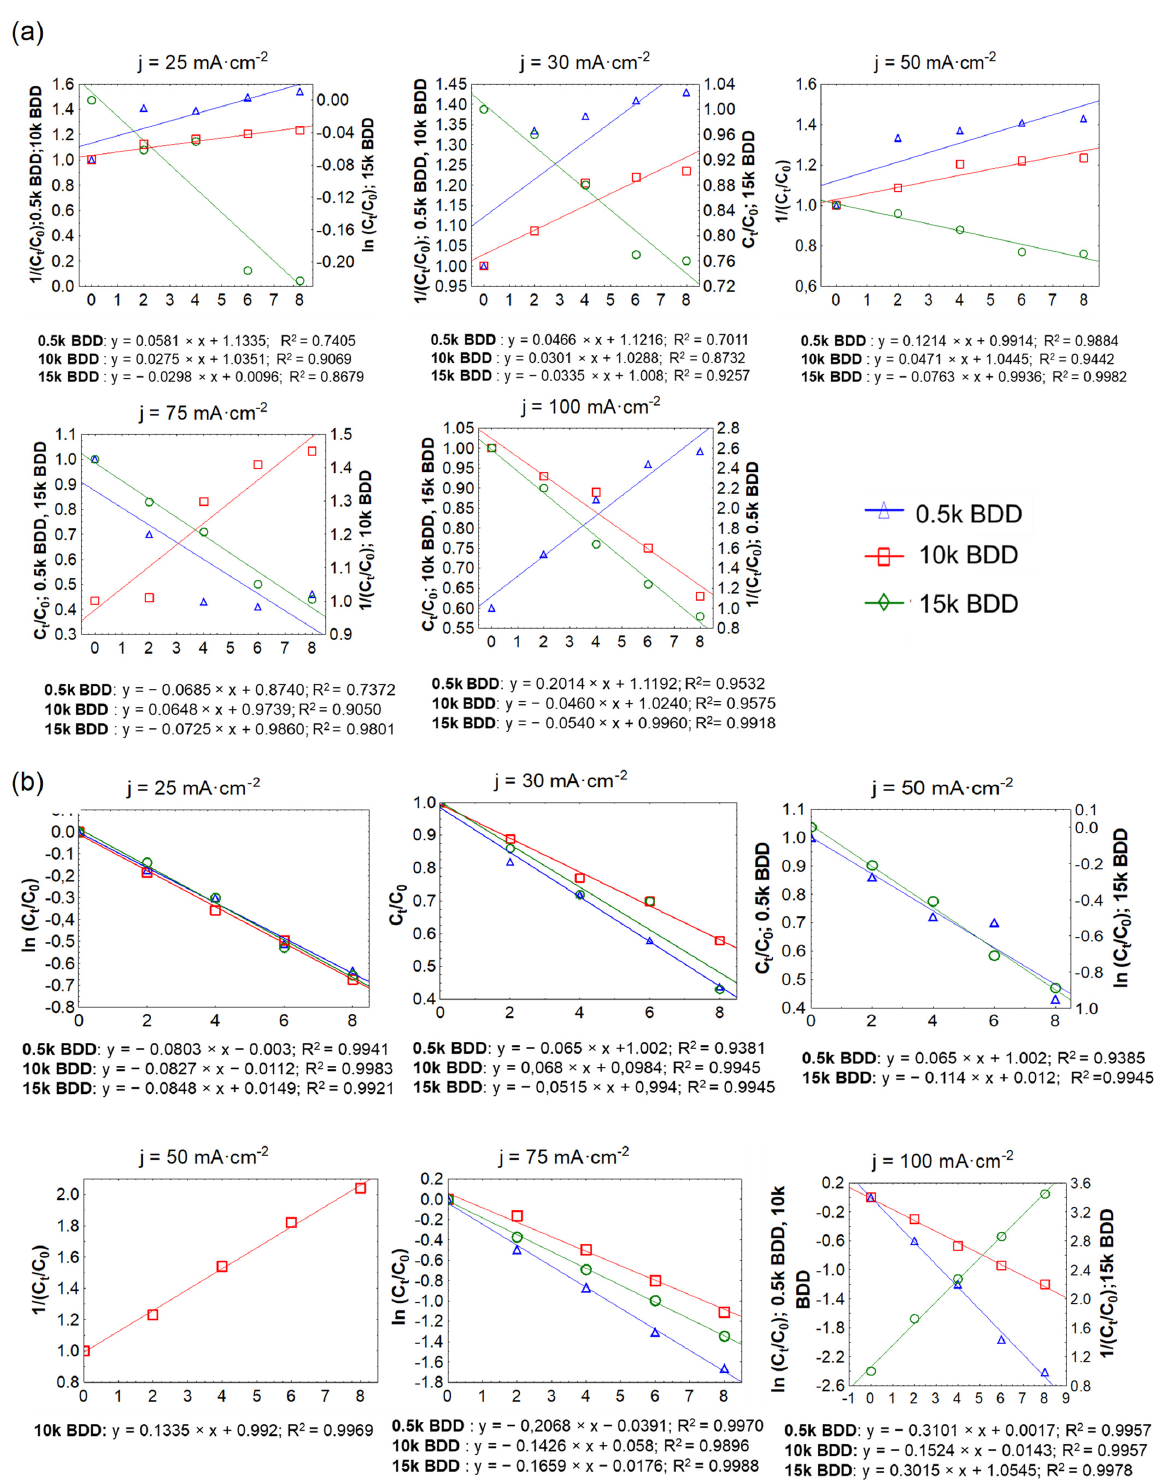
Figure 8. Determination of the order of removal of: ( a ) COD and ( b ) N-NH 4+ by the graphical